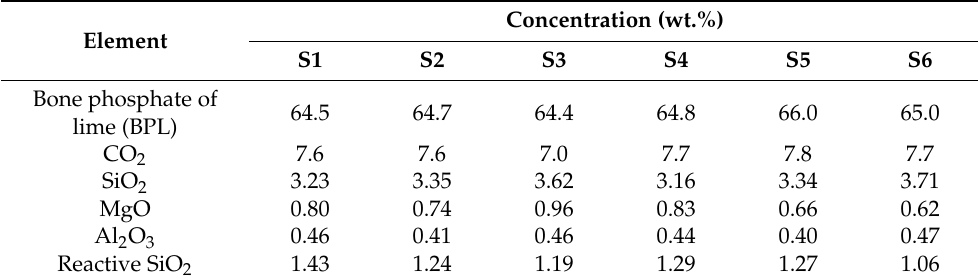
Table 1. Elemental composition of the CPS samples.